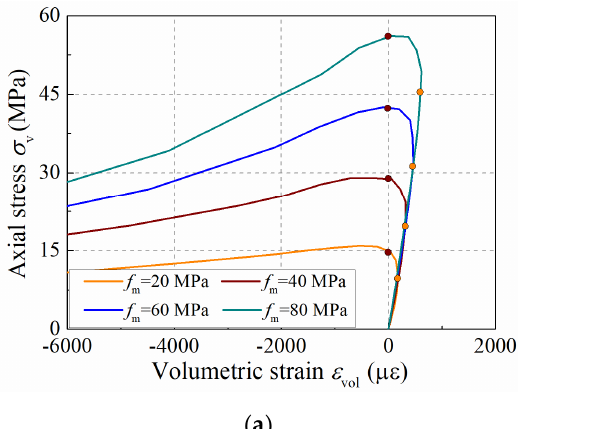
( b ) Figure 10. Dilation behavior of concrete in radial direction: ( a ) ε h – ε v curve; ( b ) μ s – ε v curve. The volumetric strain is an important parameter to illustrate the failure process of concrete, and its definition is shown by Equation (19). Figure 11a depicts the stress–volu- metric strain relationship of the specimens with different strengths under axial compres- sion. One can see that the volume of the specimen decreases slowly due to the compres-